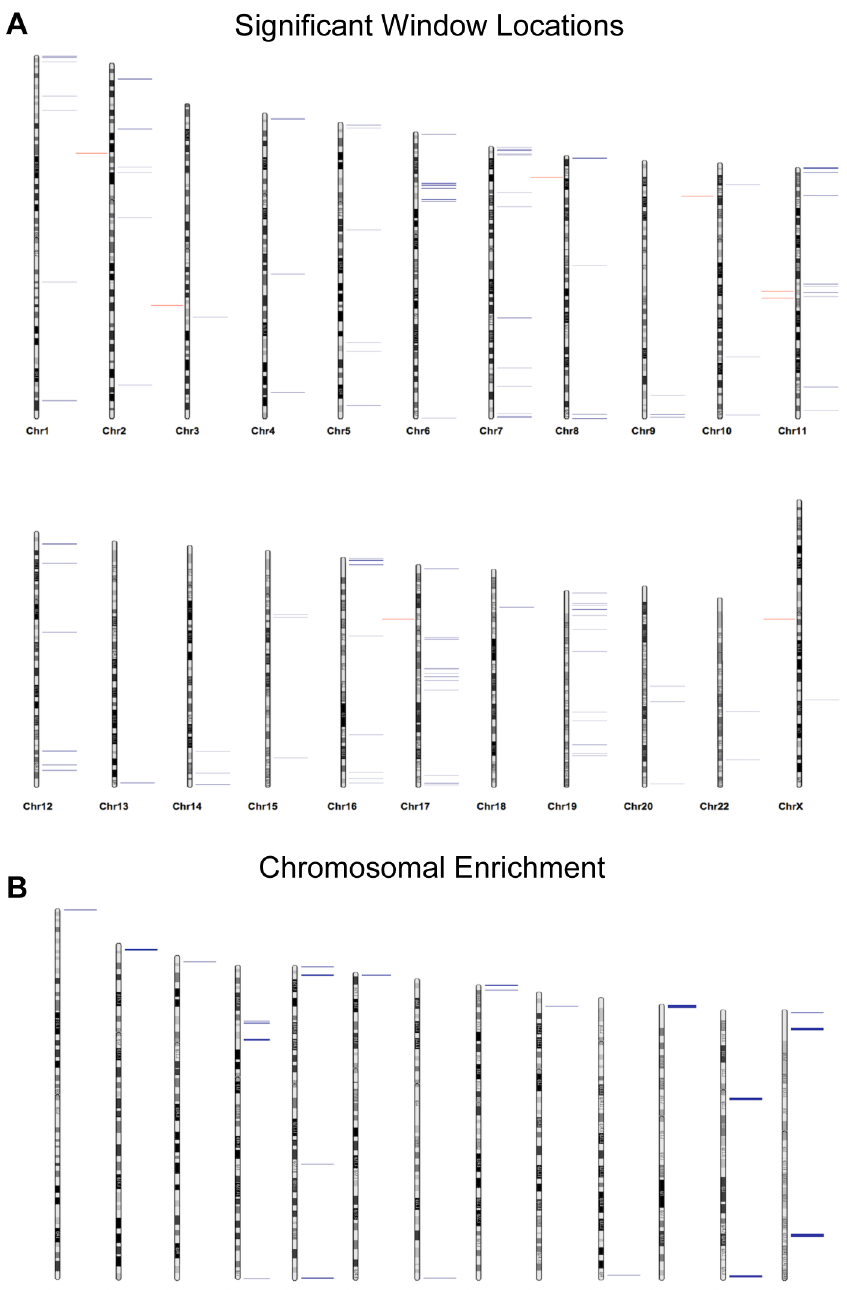
Figure 3. (A) Chromosomal loci of each altered region are depicted where blue marks represent hypomethylation events and red marks hypermethylation events. (B) The Correlation Maps app on the USeq platform was used to locate any specific chromosomal enrichment of altered methylation windows. Specifically, the application called any 100 kb region where at least two significantly altered methylation marks were found. All called chromosomal enrichment regions are displayed though none were found to be significantly enriched over the